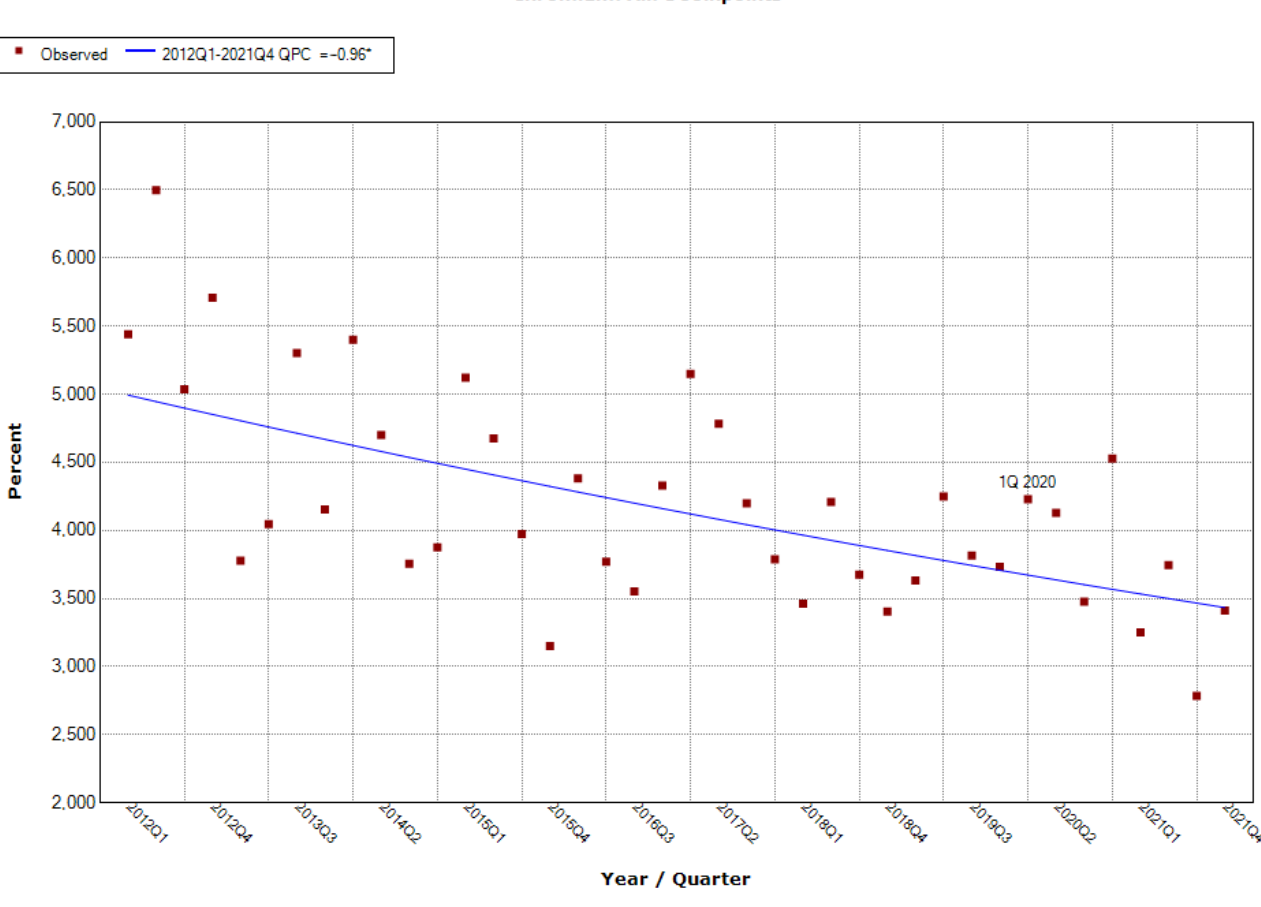
Figure A9. Percentage of products containing chromium in individual quarters in the period from 2012 to 28 November 2021. Joinpoints mark trend turning points. The date above the observation indicates the moment of publication of the scientific opinion/resolution.